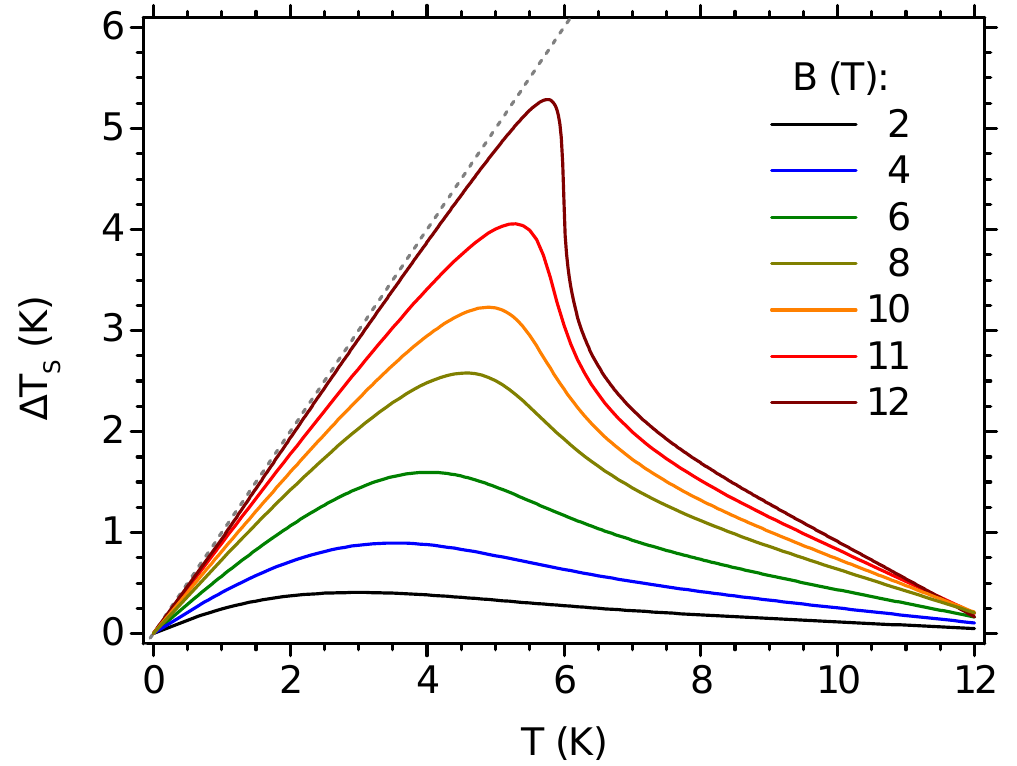
Figure 10. The dependence of the adiabatic temperature change on the initial temperature, for selected final values of the external magnetic field in the isothermal process (the initial value of the magnetic field is zero). The dashed line shows the limiting value of the adiabatic temperature change, with a final temperature equal to